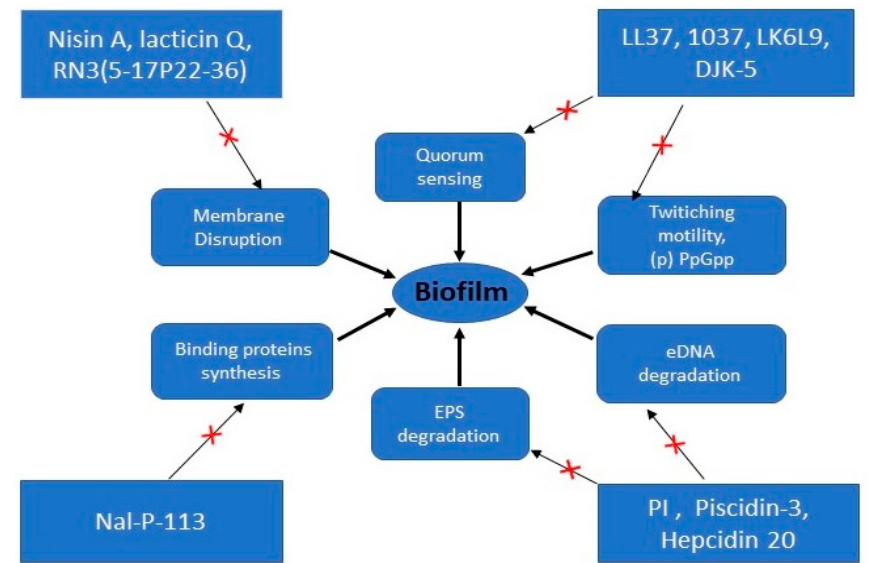
Figure 2. Representation of the different targets of anti-biofilm AMPs. × signs indicate inhibition Figure 2 . Representation of the different targets of anti - biofilm AMPs. × signs indicate inhibition and/or action on targets and/or action on targets sites.